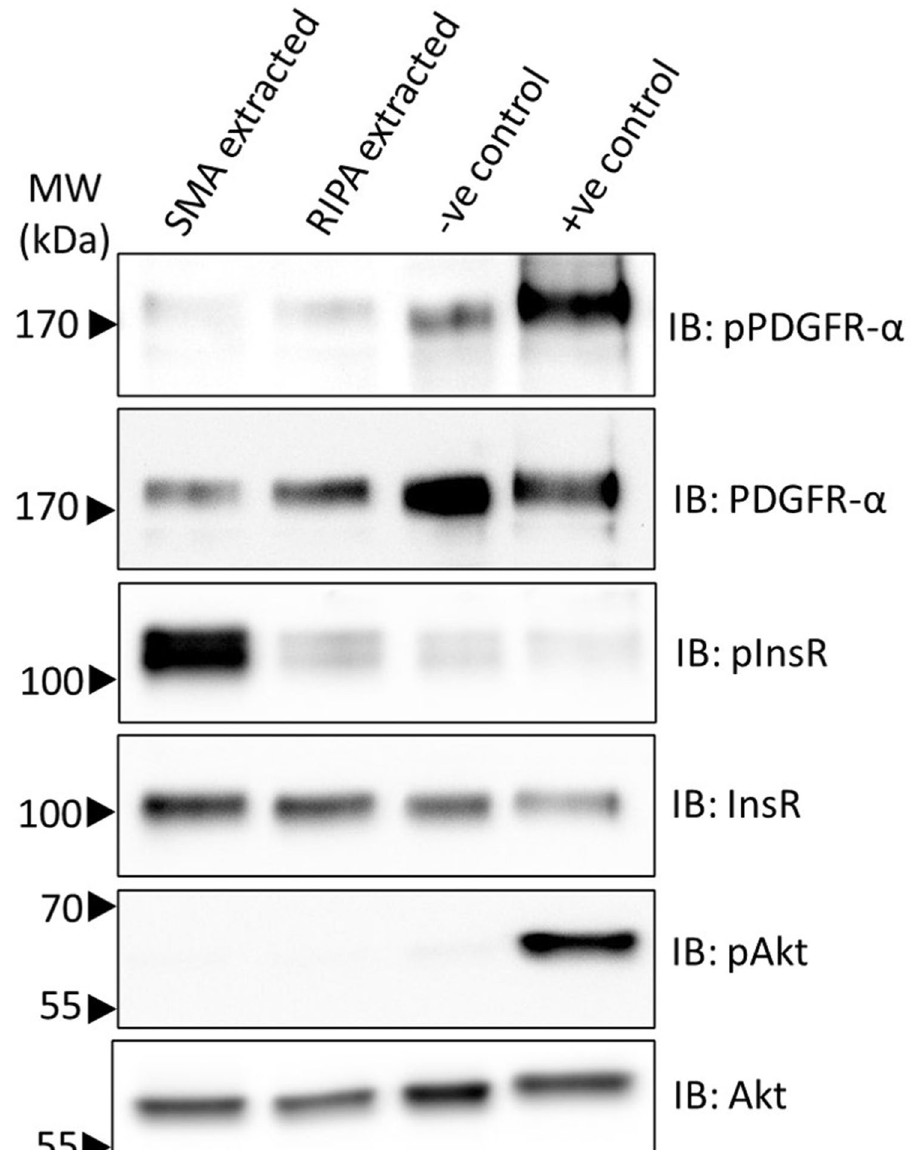
Figure 3. Analysis of activation status of PDGFRα proteins in SMA and RIPA soluble fractions. Untreated 3T3L1 fibroblasts were extracted with SMA or RIPA. Insoluble material was removed by centrifugation and proteins were analysed by immunoblotting (IB) with specific antibodies. As controls, samples from untreated cells (−ve control) and cells treated with PDGF-BB ligand (+ve control) were prepared and separated on the same